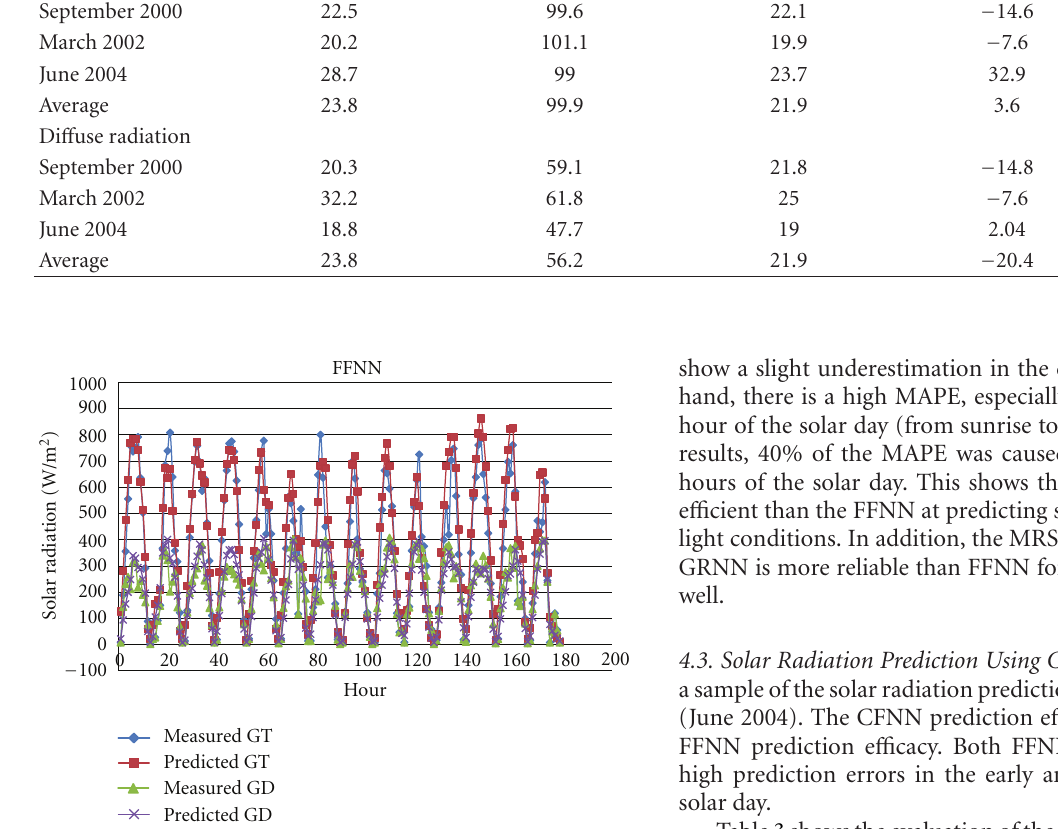
Figure 6: Solar radiation prediction using